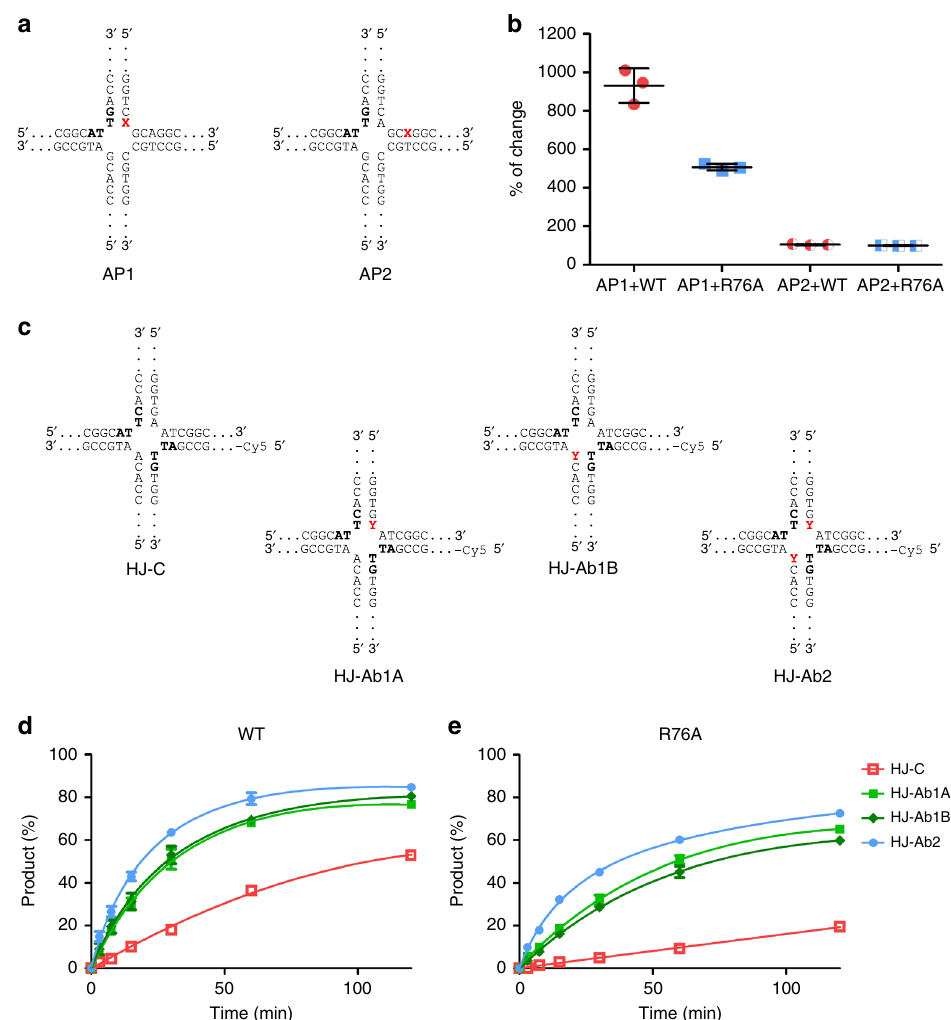
Fig. 4 Role of Arg76-mediated base pair disruption and base fl ipping in Tt -RuvC activity. a Schemes of the HJ substrates that were used in measurements of the fl uorescence of 2-aminopurine HJ upon binding to Tt -RuvC. The red X indicates 2-aminopurine. b Change in fl uorescence after mixing the 2- aminopurine substrates with different Tt -RuvC variants. The results are expressed as the percent change in DNA fl uorescence upon the addition of protein. Data from three independent experiments were averaged and plotted for each value. The error bars represent the standard deviation. Dot plots are showing individual data points. c Scheme of HJs that were used to measure the activity of Tt -RuvC (wild-type and R76A) on substrates with abasic sites. The red Y indicates an abasic nucleotide. d , e Resolving activity of the Tt -RuvC variants [wild-type ( d ) and R76A ( e )] that acted on the control and abasic site substrates. Data from four independent experiments were averaged and plotted for each timepoint. Error bars represent the standard